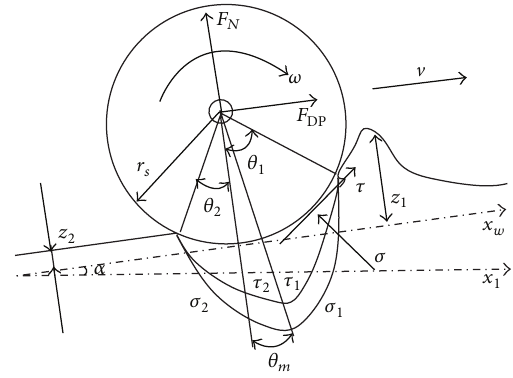
Figure 1: Wheel-soil interaction mechanism on loose sloped ter-